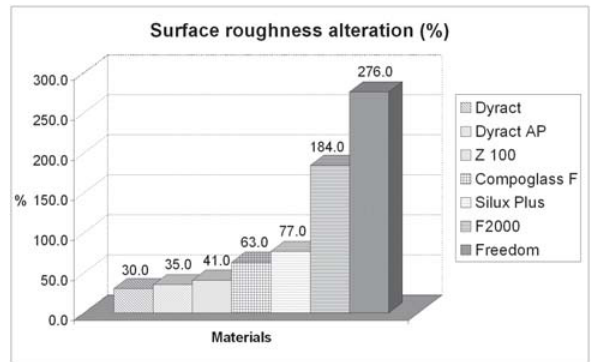
FIGURE 2- Percentage of surface roughness increase of tested materials after simulated toothbrushing abrasion